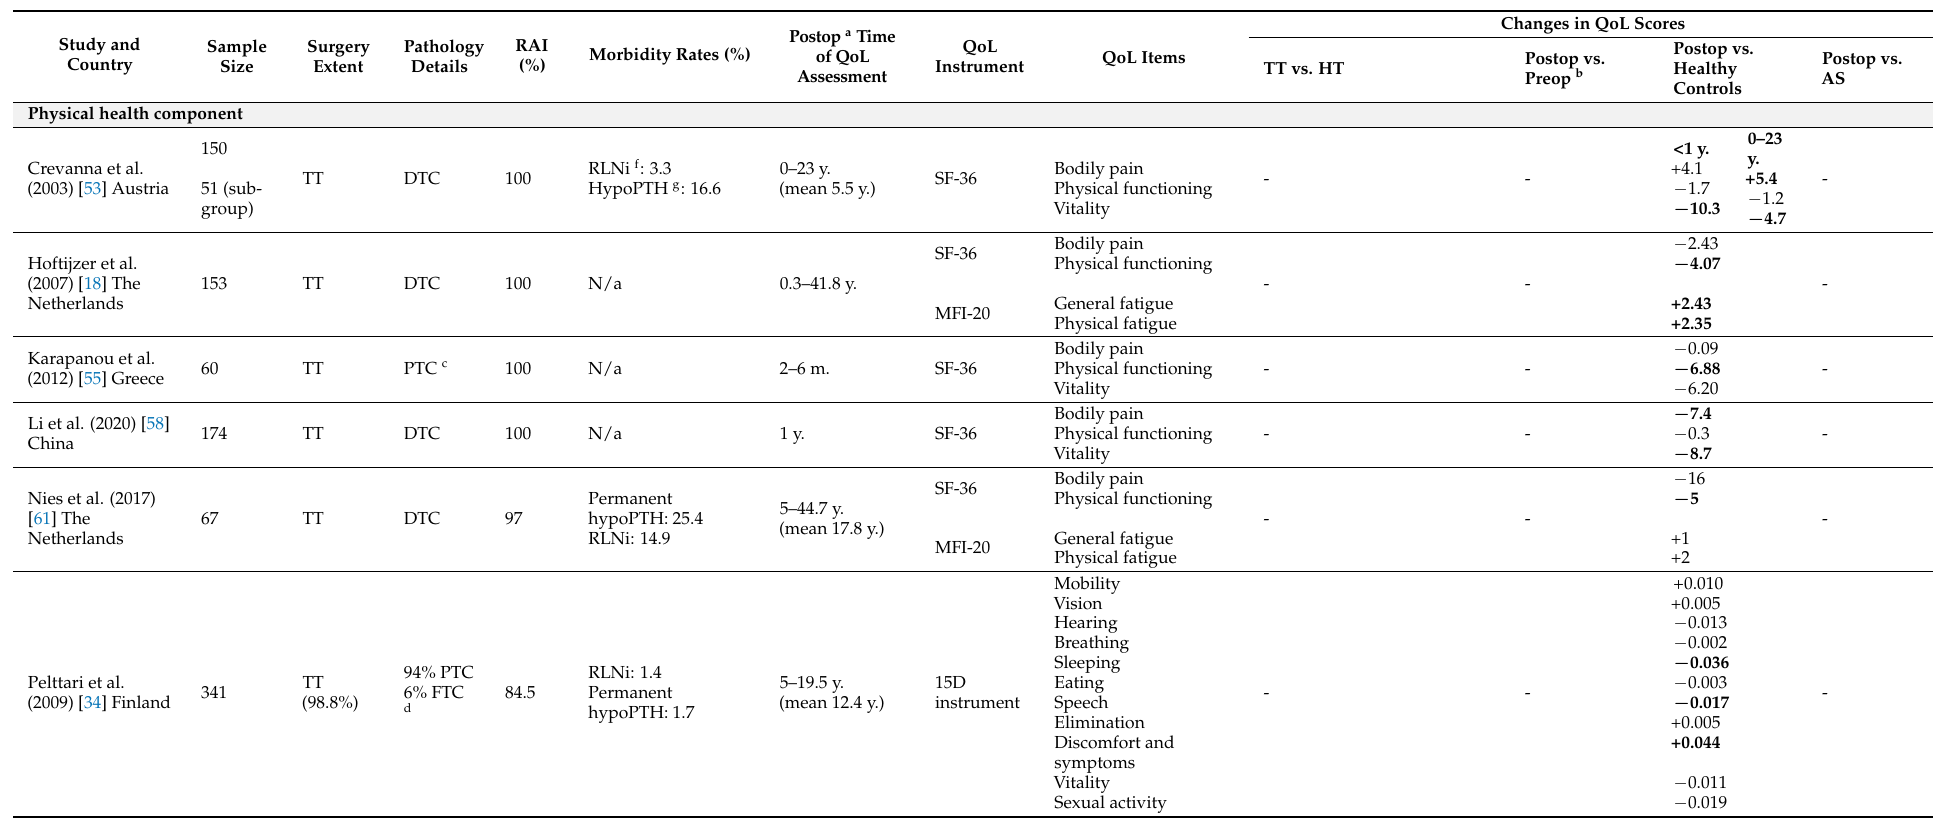
Table 5. HrQoL outcomes after thyroid surgery (quantitative